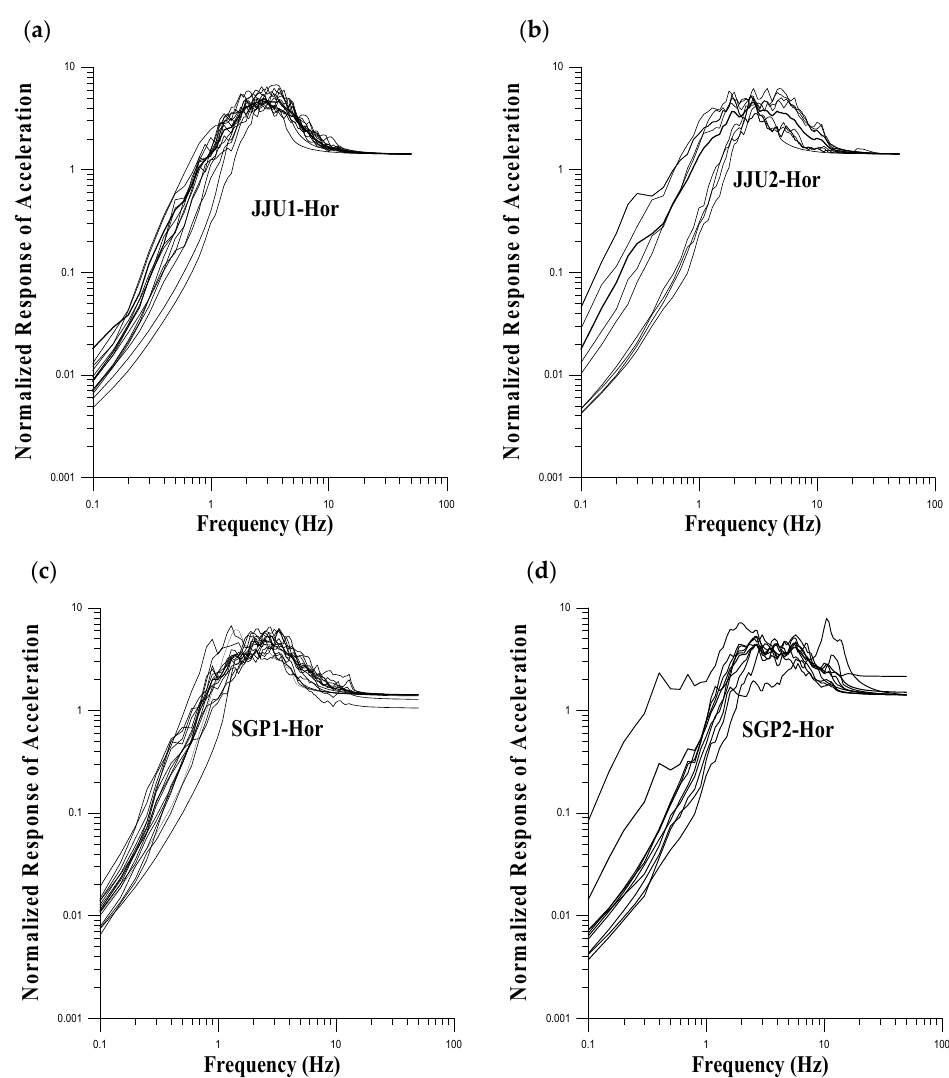
Figure 6. Normalized horizontal response spectra at ( a ) JJU1, ( b ) JJU2, ( c ) SGP1, and ( d ) SGP2 using Kumamoto and Pohang earthquakes series.